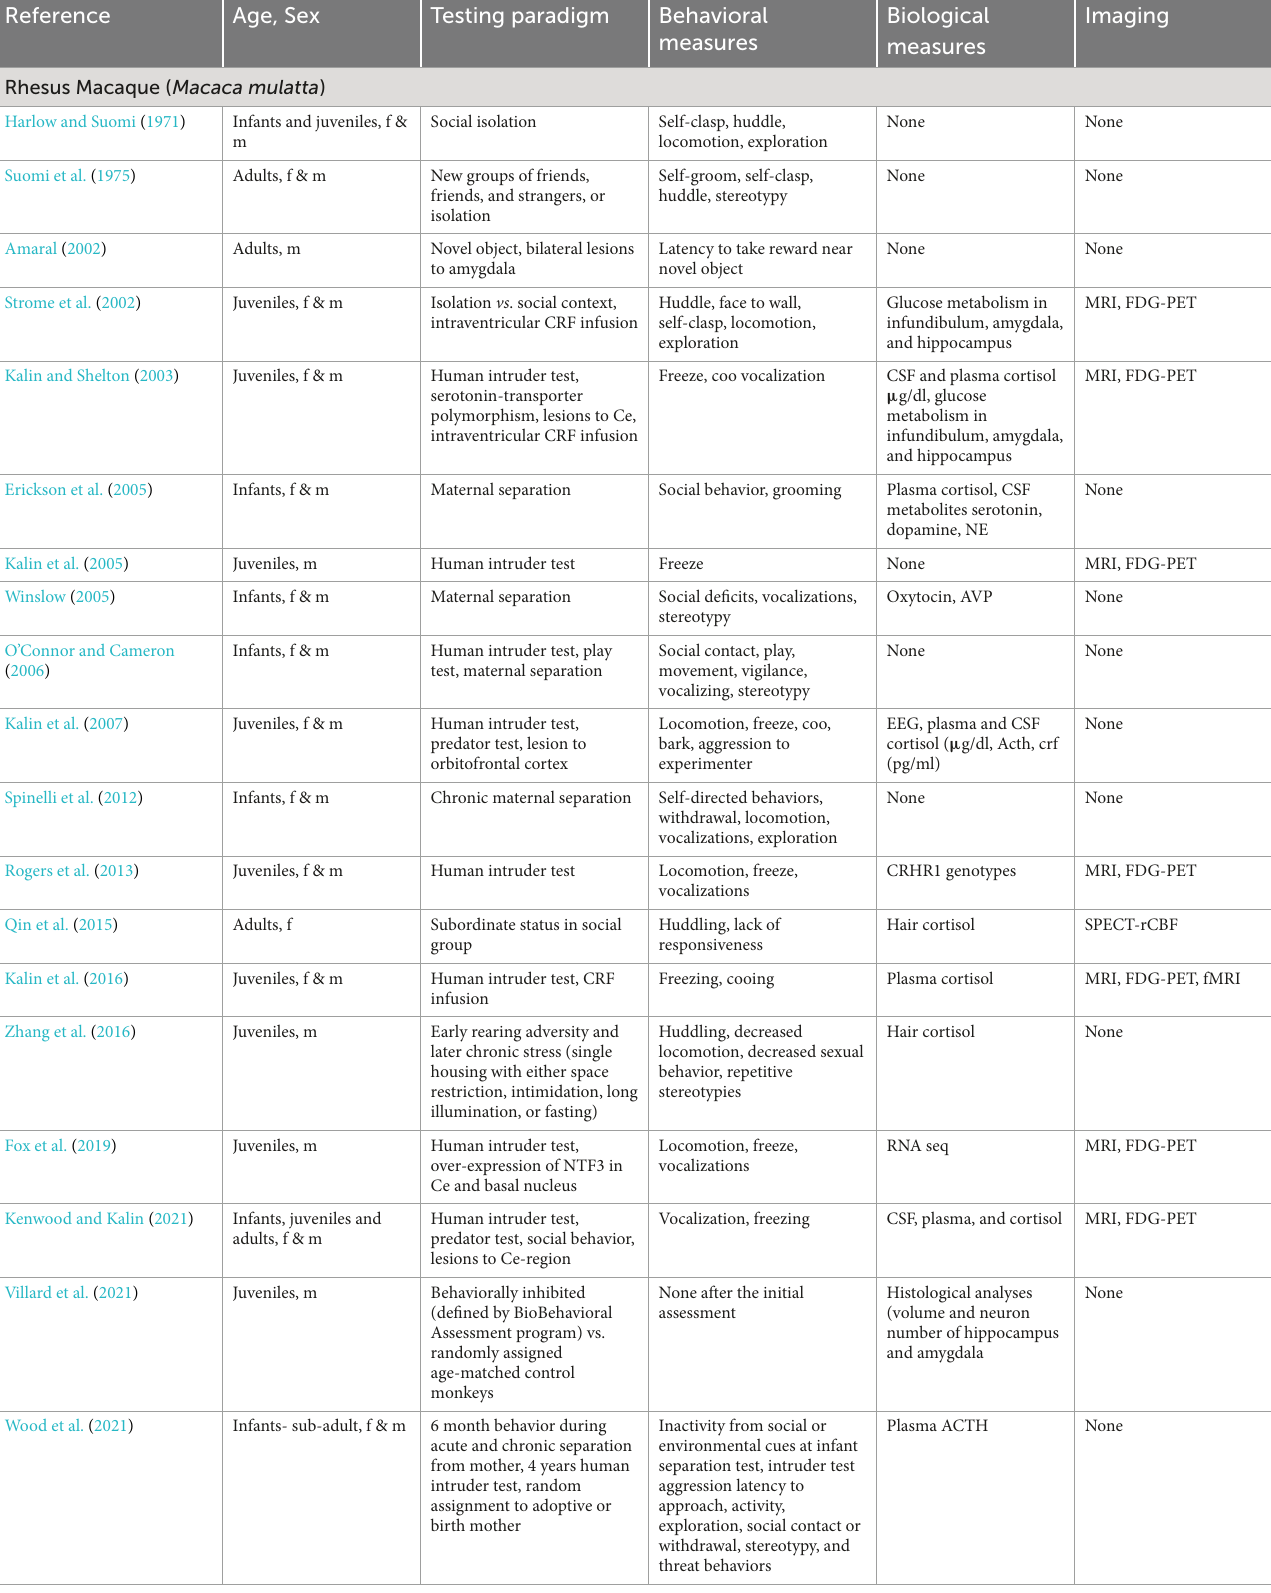
TABLE3 Selectedpeer-reviewedpublicationsdescribingmethodsofevaluationofdepression-andanxiety-likebehaviorsinrhesusmacaques(infant=0–1y; juvenile = 1–4 y; adult = 4–25